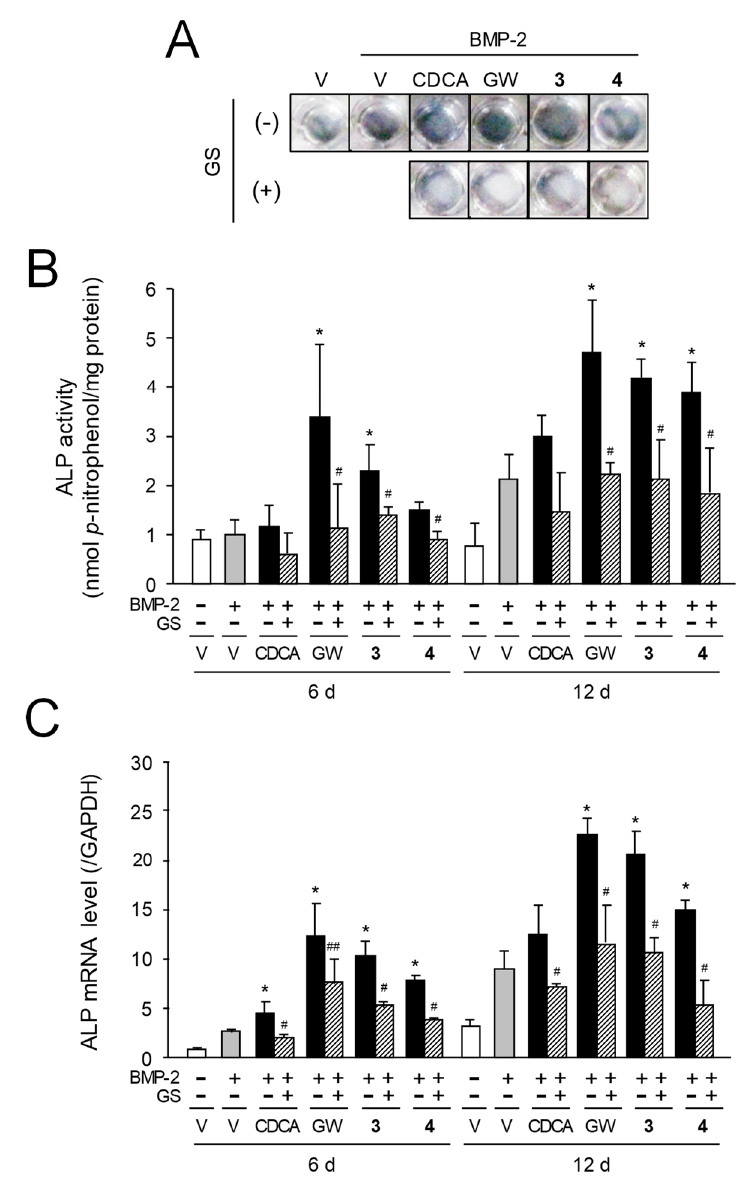
Figure 5. ALP activity in BMP-2-induced di ff erentiation of ST-2 MSCs into osteoblasts. ( A ) ALP staining. ST-2 MSCs were di ff erentiated into osteoblasts for 12 days in the medium containing BMP-2 (50 ng / mL) together with 10 µ M CDCA, 5 µ M GW4064 (GW), or 5 µ M of novel synthesized FXR agonist 3 or 4 in the presence or absence of 25 µ M GS. ALP staining was carried out as described in Materials and Methods. The results are the representative from three experiments. ( B ) ALP activity. The ST-2 MSCs (vehicle: V; white columns) were cultured for 6 or 12 days in the medium containing BMP-2 (50 ng / mL; gray columns) together with one of the FXR agonists, 10 µ M CDCA, 5 µ M GW4064 (GW), and 5 µ M of novel synthesized FXR agonist 3 or 4 (black columns) in the presence or absence of 25 µ M GS (hatched columns). Data are shown as means ± S.D. for three experiments. * p < 0.01, as compared with the BMP-2-treated cells, # p < 0.01, as compared with the FXR agonist-treated cells. ( C ) Expression of the ALP gene during osteoblast di ff erentiation of ST-2 MSCs. The cells were cultured as described in the legend of Figure 5B. Expression level of the ALP gene was measured by qPCR. Data are presented as means ± S.D. from three experiments. * p < 0.01, as compared with the BMP-2-treated cells, # p < 0.01, ## p < 0.05, as compared with the FXR agonist-treated cells.